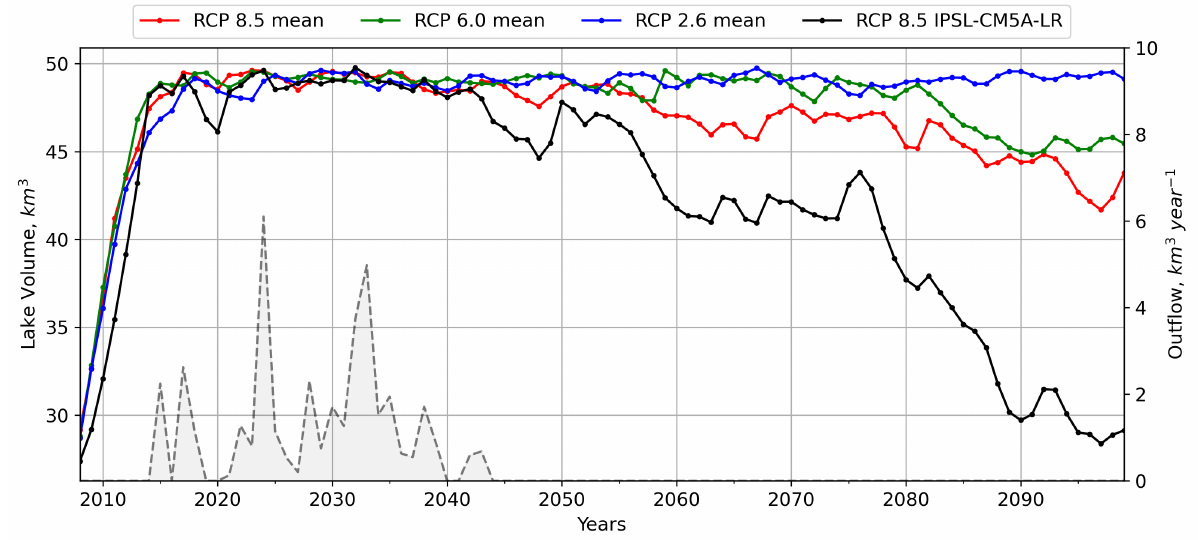
Figure 6. Mean annual values of the Small Aral Sea volume with increased lake surface (48.5 m.a.s.l.) depending on the RCP scenarios, averaged between 4 models; IPSL-CM5A-LR model under RCP 8.5 scenario is shown in black as the most adverse case; annual values of the outflow under that scenario is shown by a dashed